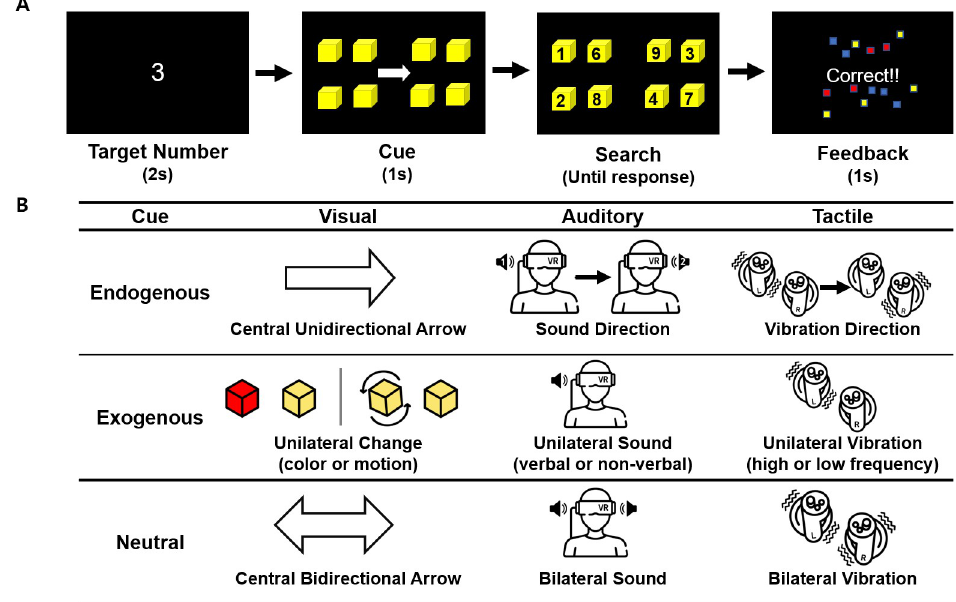
Fig 1. Illustration of the experimental design. (A) Sequence of events and time course of a trial in the visual search task. On each trial, a target number to search for was first presented (2s), then a spatial cue that gives information about the location (left or right side) of the upcoming target was presented (1s). In this example, the visual endogenous cue (central unidirectional arrow) is illustrated. Then, participants searched for the cube on which the target number is written and touched it with a virtual hand. The feedback about the accuracy of the response was given (1s). (B) Illustration of different cue types in the experiment. The cue types were categorized based on its sensory modality (visual, auditory, tactile) and origin (endogenous, exogenous). Neutral cues did not give any information about the location of the upcoming target.